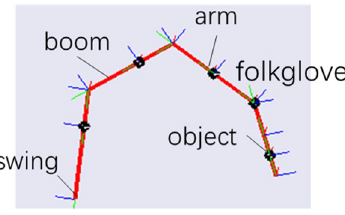
Figure 12. SimMechanics plant.